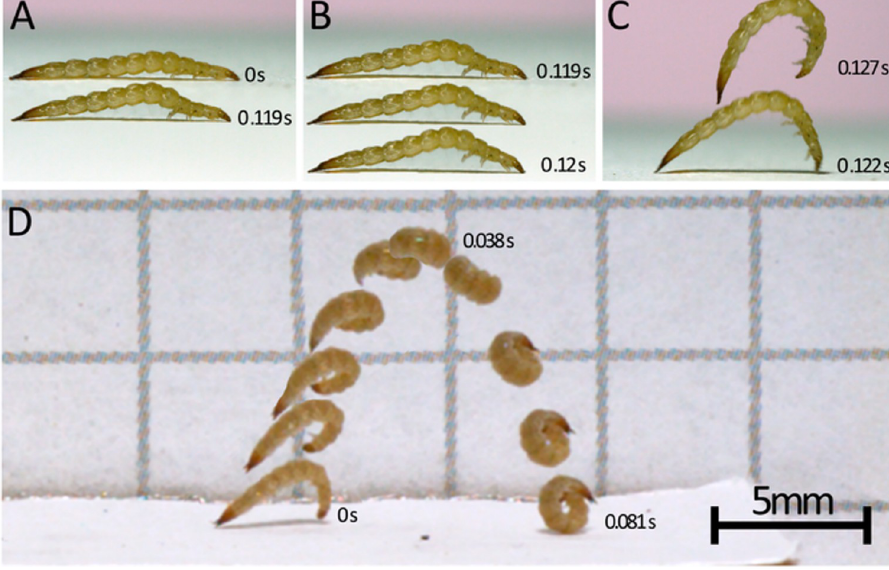
Fig 3. Habitus images of known Laemophloeidae with jumping larvae: A: larva of Laemophloeus biguttatus ; B: same, adult; C: larva of Placonotus testaceus , D: same, adult. (A&B: taken by MAB; D&C: taken by